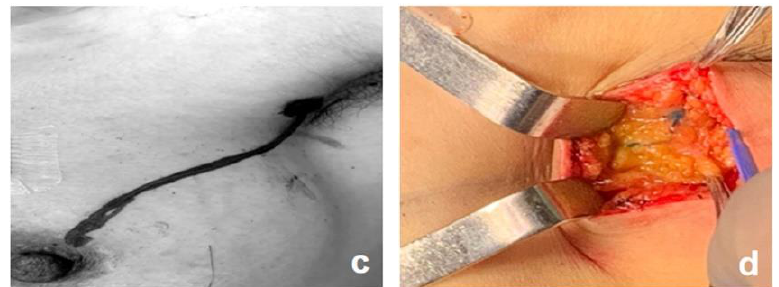
Figure 3. A 42-year-old woman with invasive ductal carcinoma of the breast ( left ). ( a ) Conventional ultrasound shows suspicious axillary lymph node. ( b ) Contrast-enhanced ultrasound revealed one LC to one SLN, with the SLN showing homogeneous enhancement (the asterisk represents the enhanced SLN). ( c ) Preoperative body surface marking of LC draining to the SLN. ( d ) Intraoperative blue staining of LC and SLN (LC = lymphatic channel; SLN = sentinel lymph node).